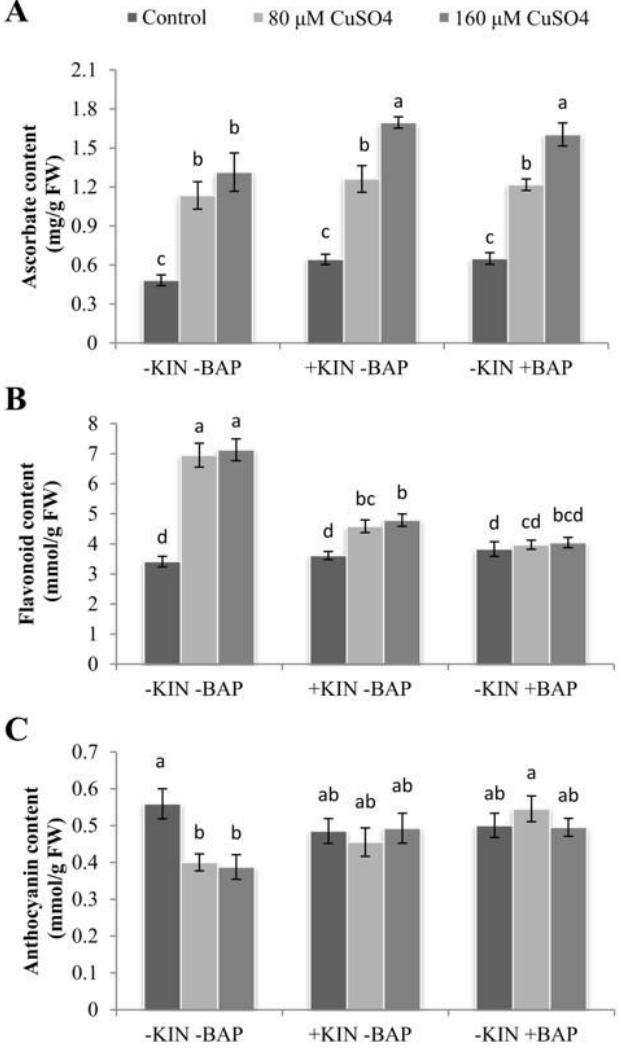
Figure 8. Ascorbate ( A ), flavonoid ( B ), and anthocyanin ( C ) contents in the cotyledonary leaves of R. communis after 6 day of exposure to CuSO 4 (80 and 160 µ M) and cytokinin (KIN and BAP) treatments in Hoagland’s nutrient medium. Values are the mean ± SE of three independent experiments. Different alphabetical letters indicate significant differences between treatments according to one- way ANOVA (Duncan’s test p ≤ 0.05).